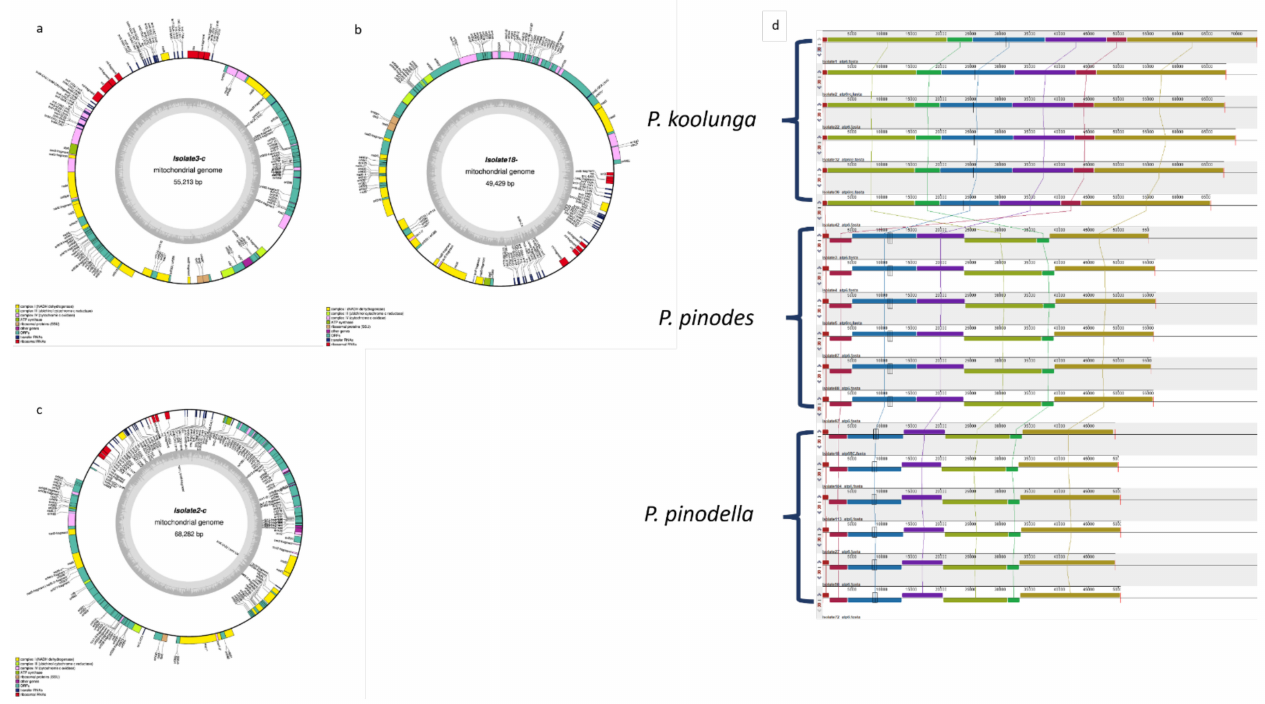
Figure 7. Graphical representation of the AB reference isolate mitochondrial genomes using OG- DRAW from the CHLOROBOX web server. ( a ) P. koolunga , Isolate2Pk; ( b ) P. pinodella , Isolate18Ppll; and ( c ) P. pinodes , Isolate3Pp. ( d ) Mitochondrial gene order synteny among AB